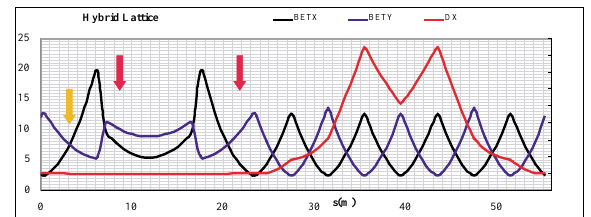
FIG. 2. (Color) Lattice functions along a ring superperiod. The doublet structure allows for long uninterrupted straight sections. Collimator locations are indicated by the arrows.